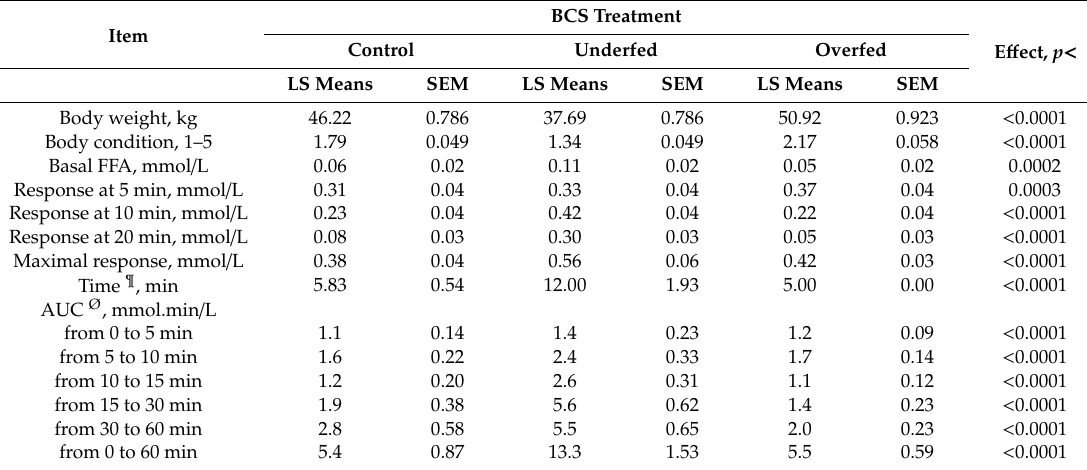
Table 5. Average body weight (BW), body condition score (BCS), plasma FFA (at − 15 min) and plasma FFA responses to a β -adrenergic challenge with an isoproterenol injection in mature, dry, nonpregnant Merinos d’Arles ewes ( n = 36) with di ff erent body condition scores.